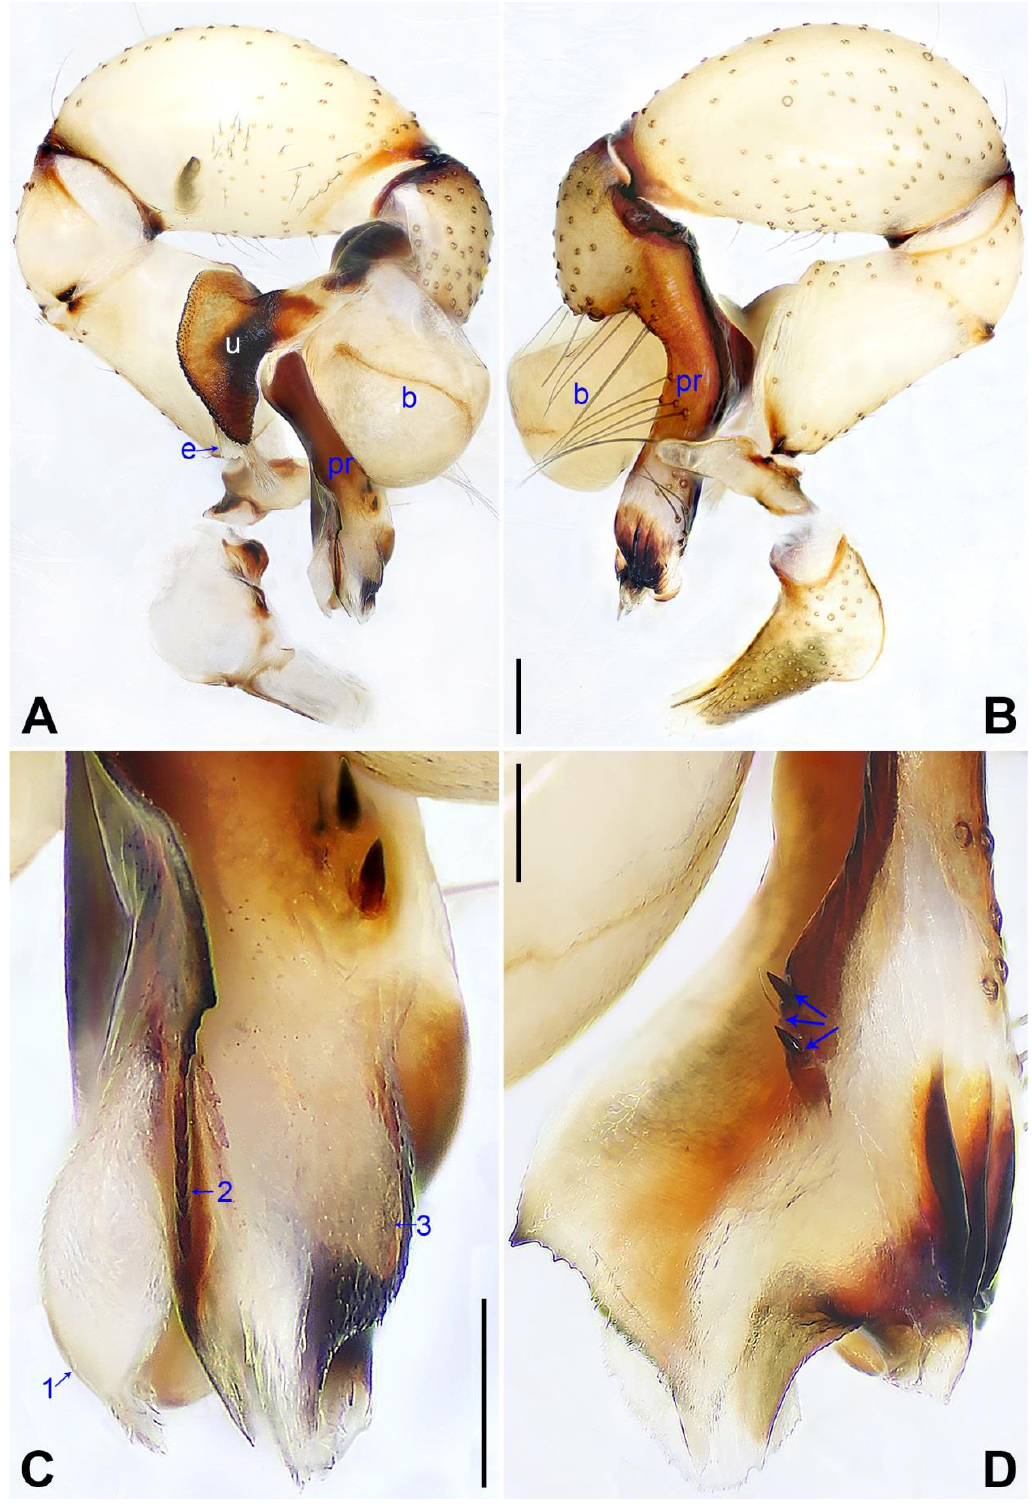
Figure 15. Pholcus xuanzhong sp. nov., holotype male: ( A ) pedipalp, prolateral view; ( B ) pedipalp, retrolateral view; ( C ) distal part of procursus, prolateral view (arrow 1 points at prolateral membranous process, arrow 2 points at prolateral sclerite, arrow 3 points at dorsal membranous lamella); ( D ) distal part of procursus, dorsal view (arrows point at dorsal spines). b = bulb, e = embolus, pr = procursus, u = uncus. Scale bars: ( A , B ) = 0.20 mm; ( C , D ) = 0.10 mm.